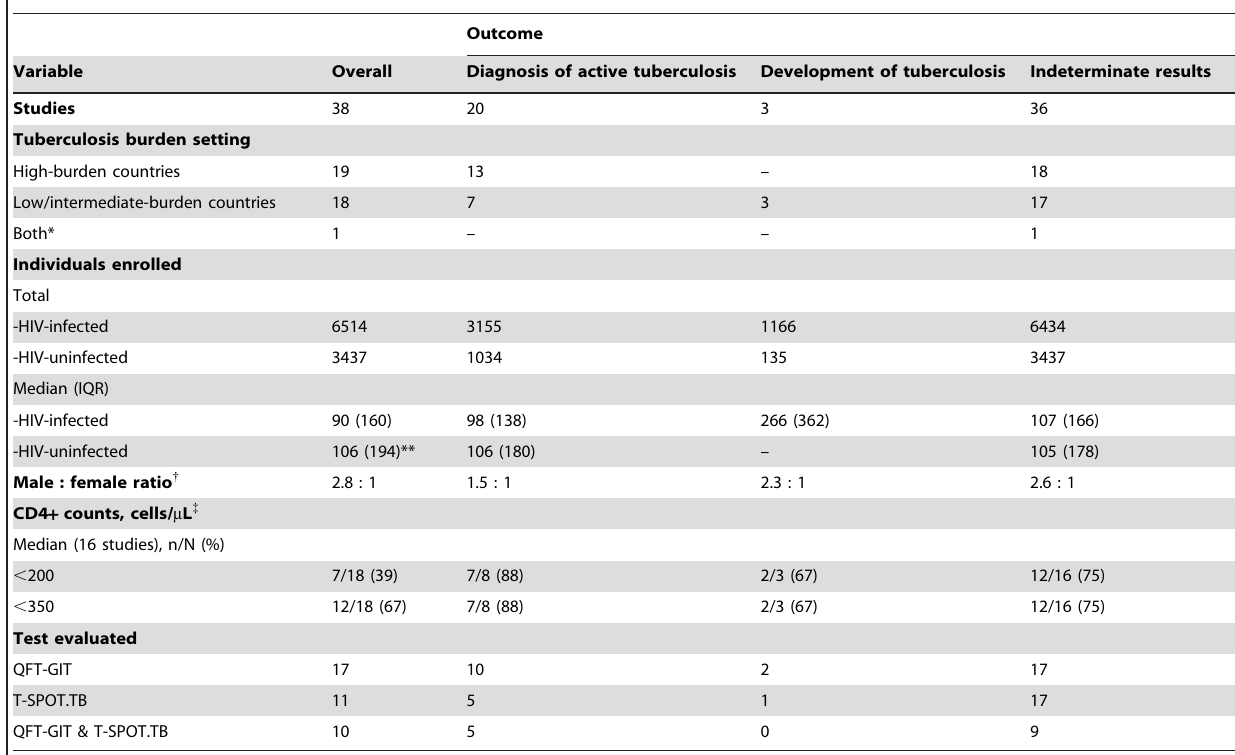
Table 1. General and outcome-related characteristics of the 38